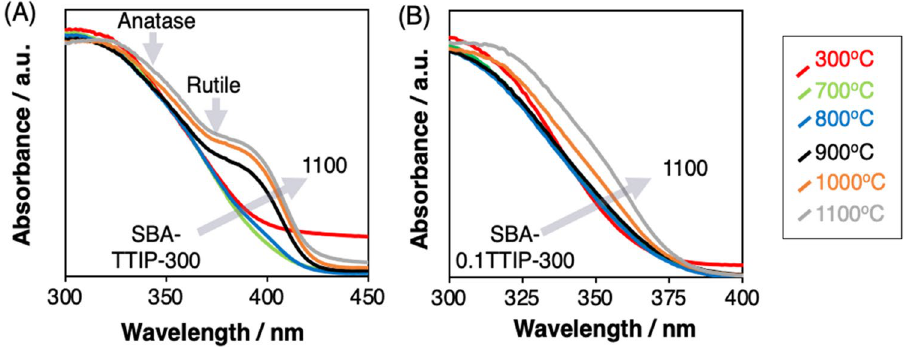
Figure 6. Diffuse reflectance spectra of the heated ( A ) SBA-TTIPs and ( B ) SBA-0.1TTIPs (the spectra due to anatase and rutile are indicated by the arrows).